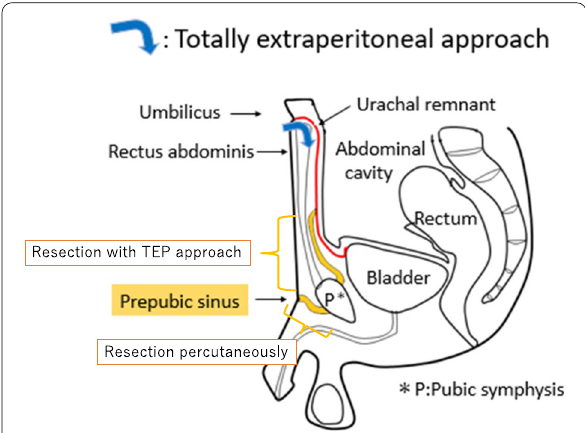
Fig. 3 A schema of the TEP approach